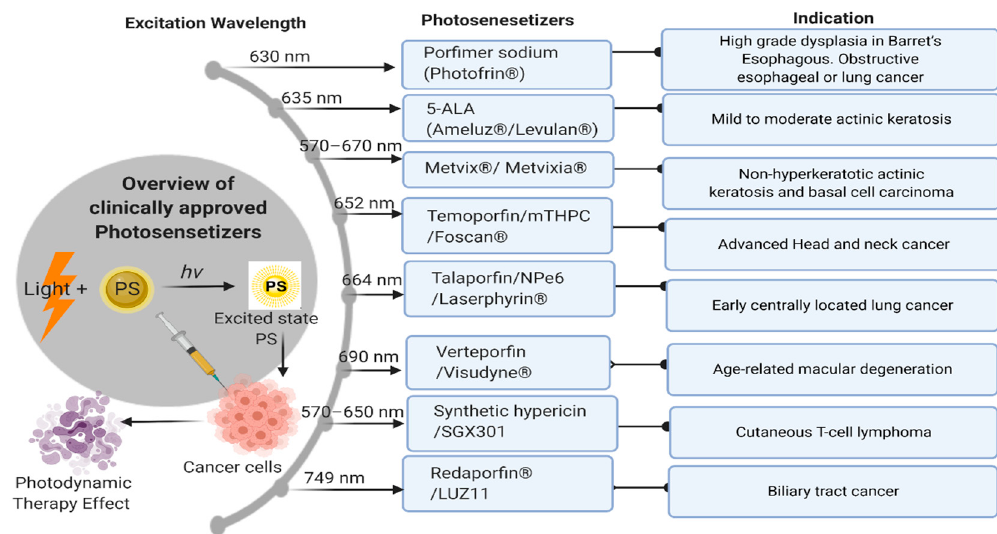
Figure 1. The mechanism of photodynamic therapy (PDT) effects and a list of clinically approved Photosensitizers (PSs) with their excitation wavelengths and indications.